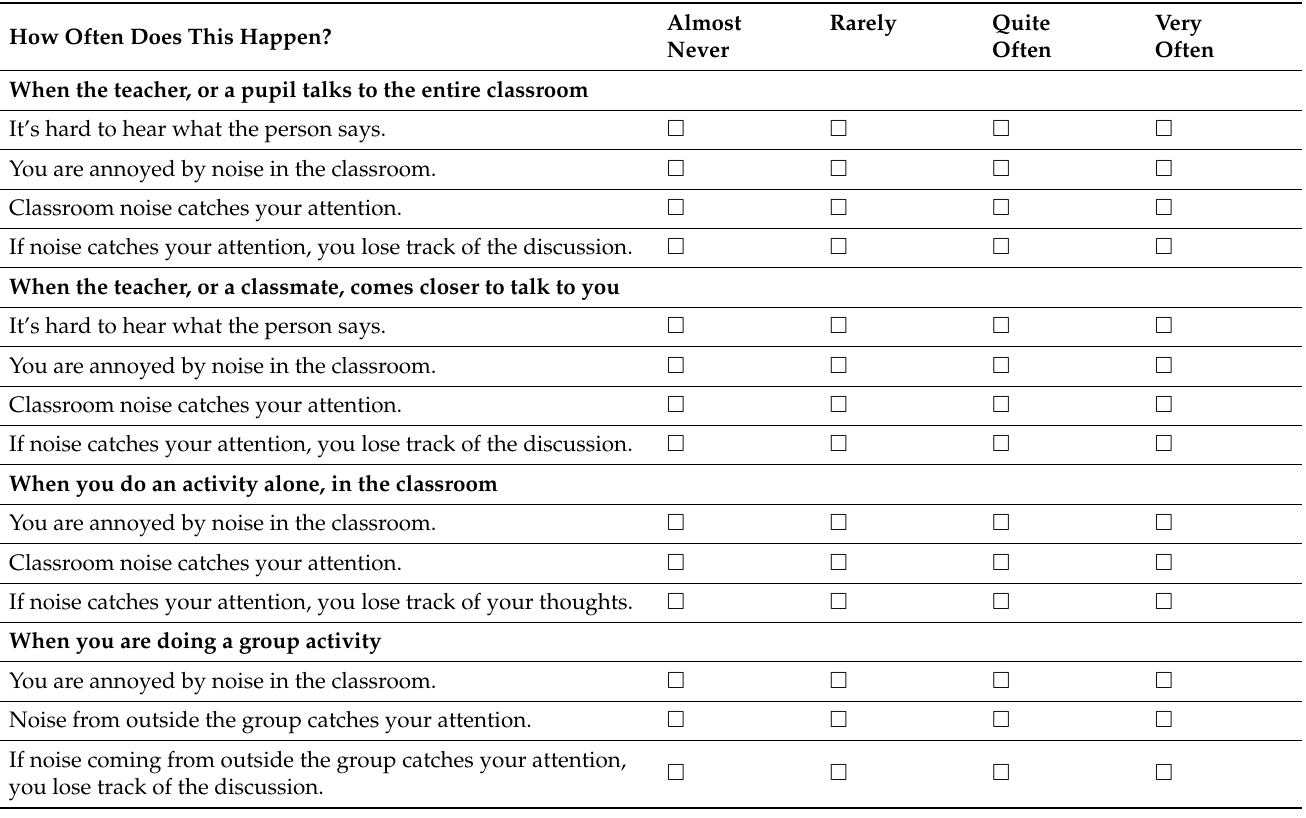
Table A2. Reactions to Classroom Noise Questionnaire used in Study 2 (from Massonni é et al., 2020